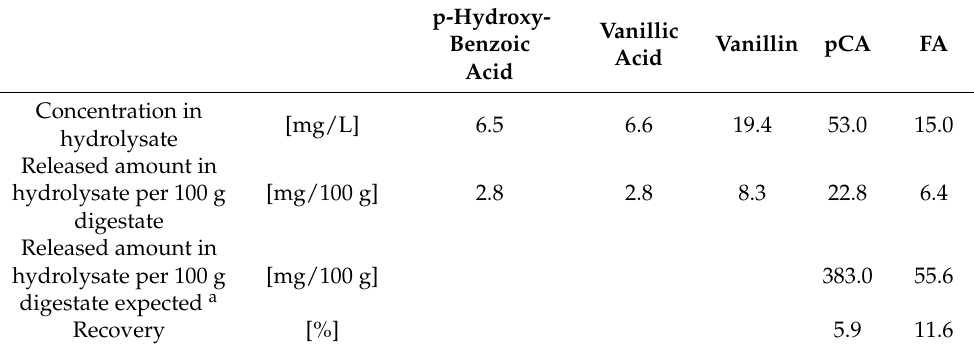
Table A2. Quantification of certain phenolic monomers in the hydrolysate after 70 min hydrother- mal steam treatment of washed digestate. It is compared how much of the pCA and FA released from the digestate can be recovered in the hydrolysate. The measurement was conducted as a single determination.